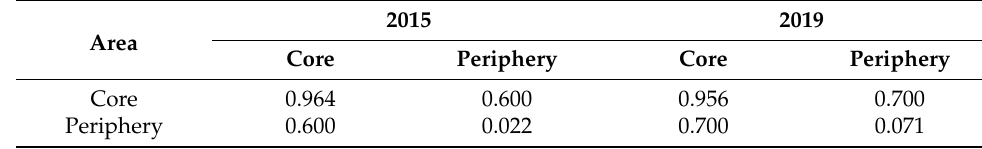
Table 4. Network core–periphery density matrix.